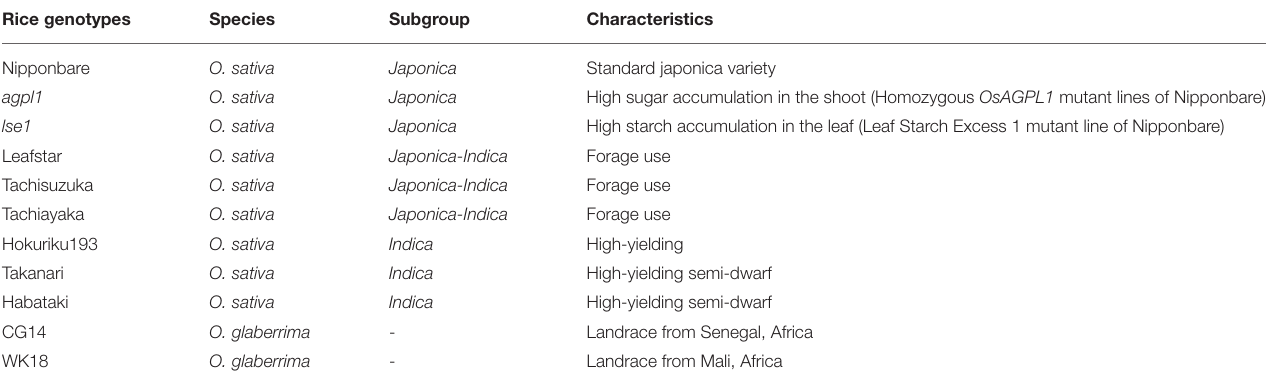
TABLE 1 | Rice varieties and lines used at field and pot